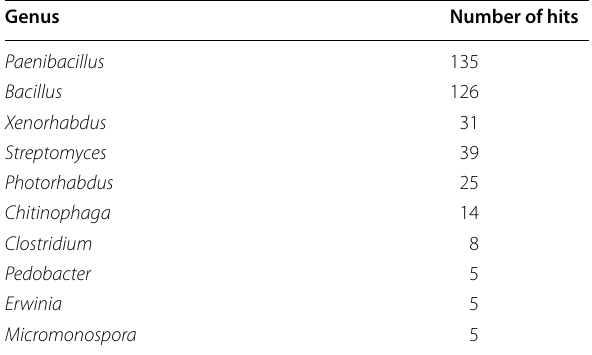
Table 2 Genera representing the bulk of putative azasugar producers. Hits for genera having less than 5 members